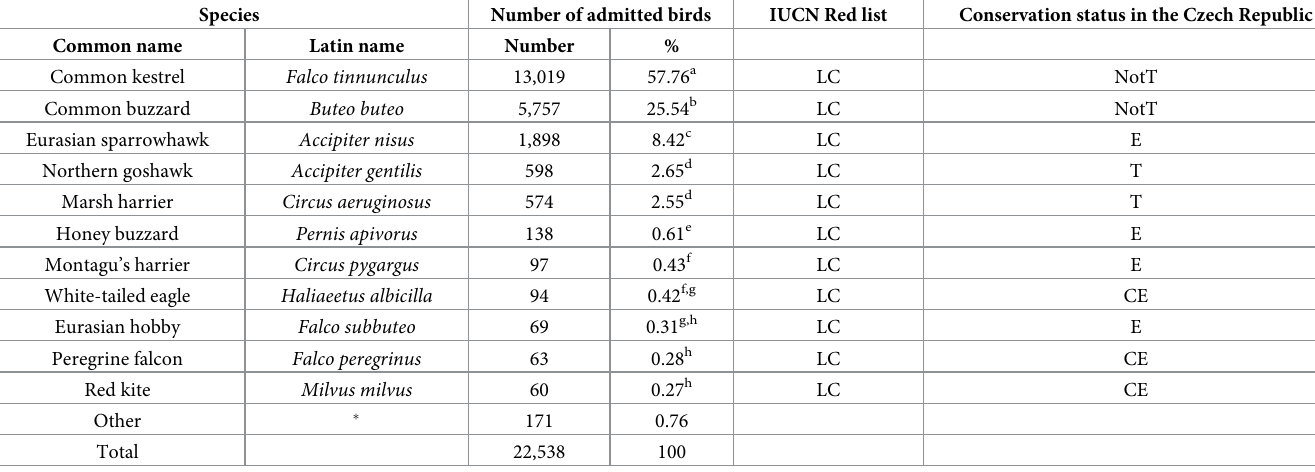
Table 3. Number of raptors admitted to rescue centres in the Czech Republic in the period from 2010 to 2019 by species. Species